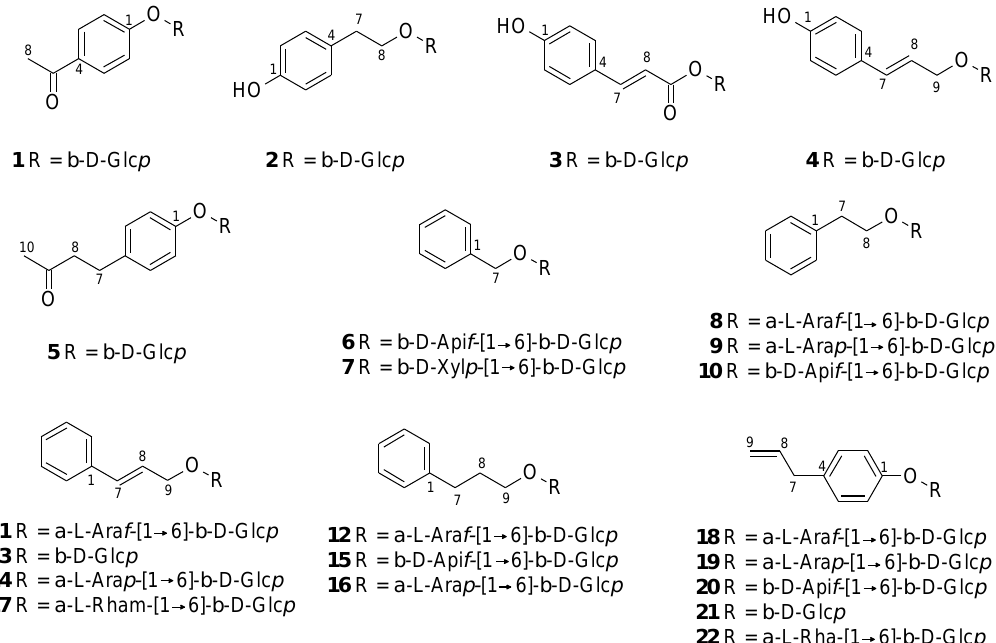
Figure 2. Chemical structures of phenylalkanoid glycosides identified in the hydroalcoholic extract × dasyclados hybrid (NWC1283) chipped of S. triandra × dasyclados hybrid (NWC1283) chipped biomass. S. triandra